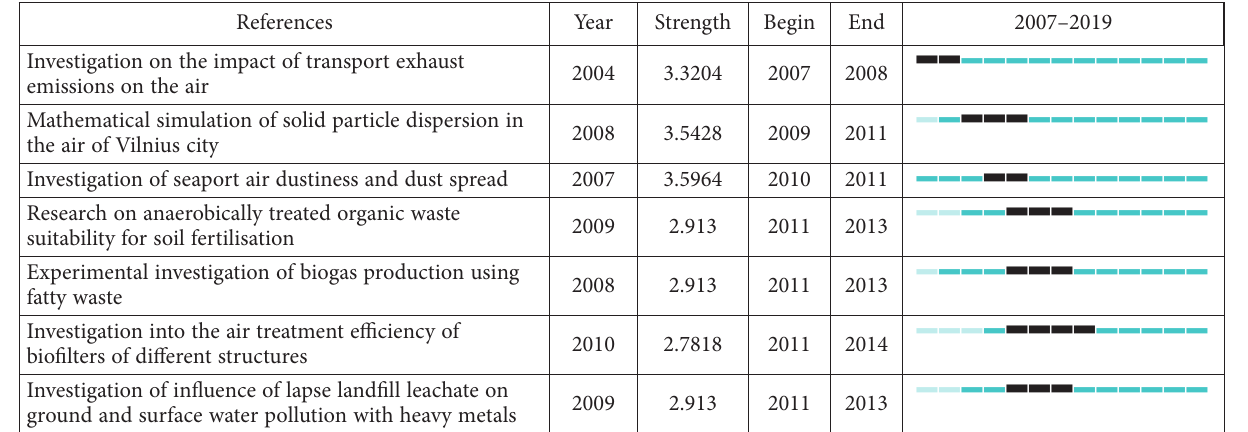
Table 9. Top 7 references with the strongest citation